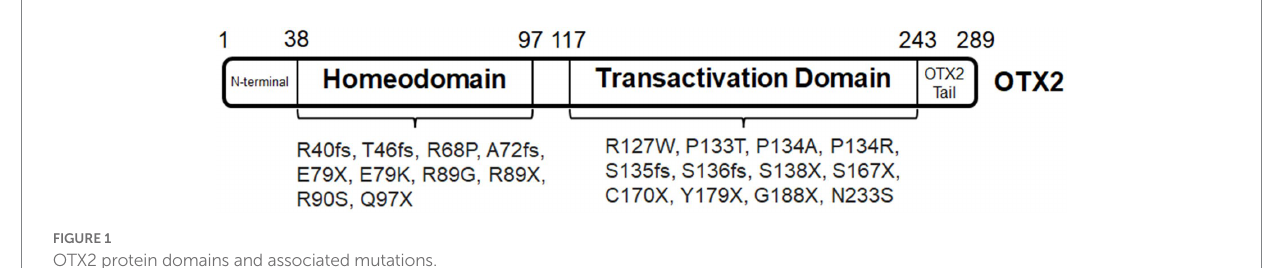
FIGURE 1 OTX2 protein domains and associated